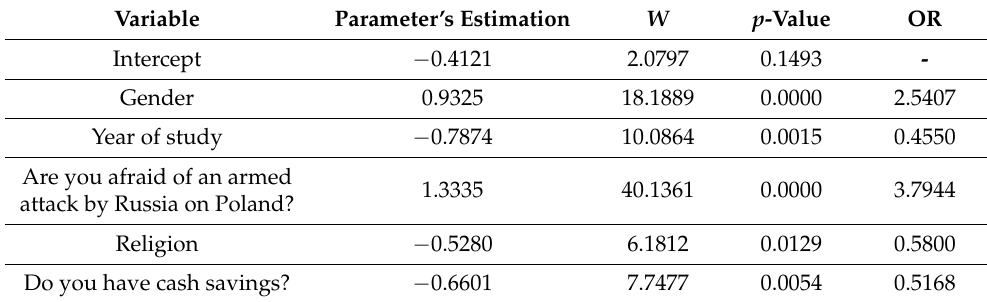
Table 2. Logit model parameter evaluations.